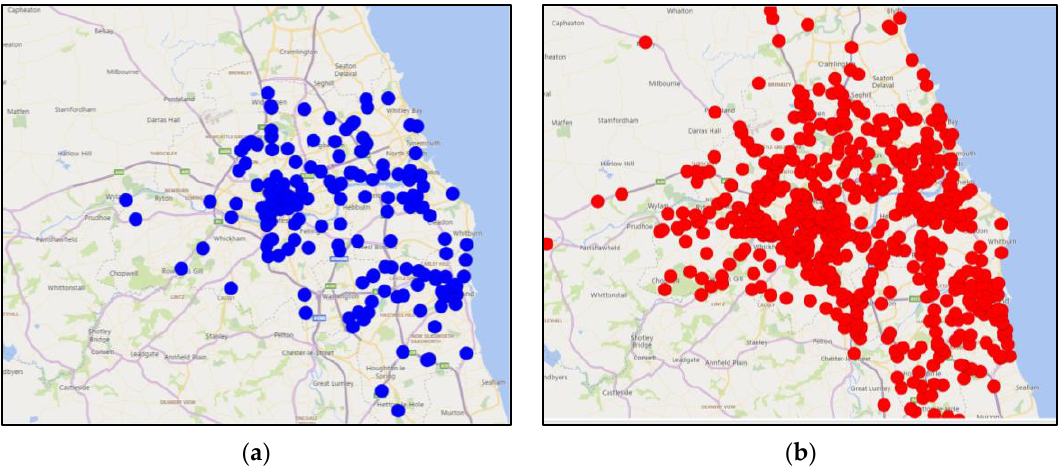
Figure 1. The overview of the ( a ) Cyclist flow cameras and ( b ) Motor vehicle cameras in the study area.